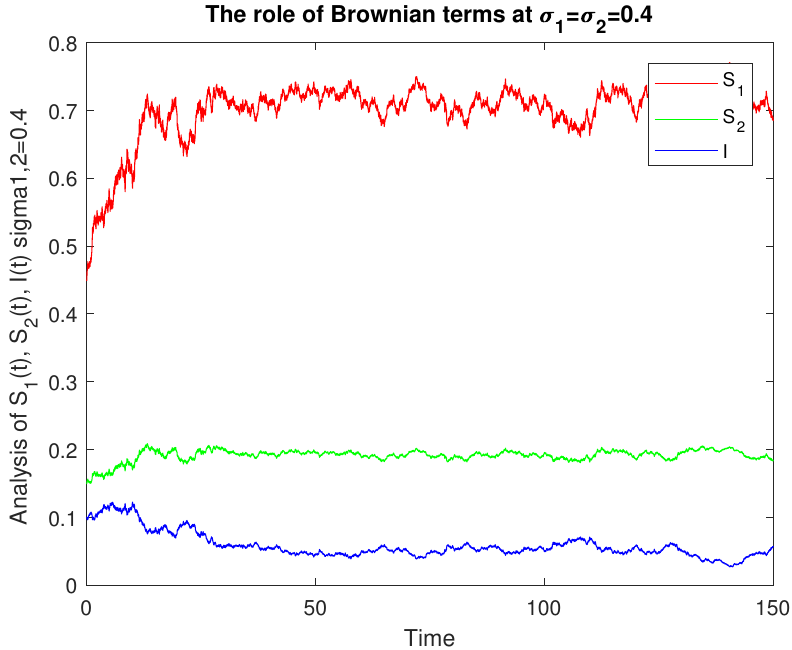
Figure 3. Numerical solution of the model (1) for σ 1 = σ 2 =